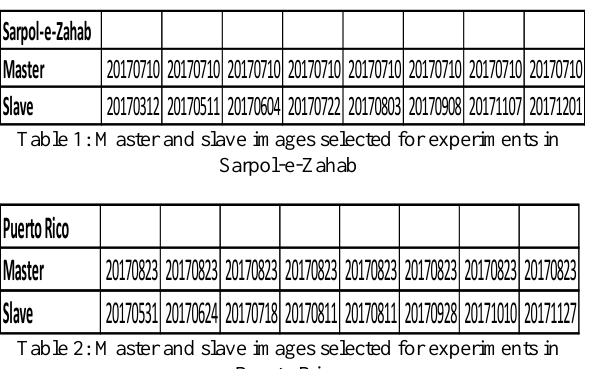
Figure 1: Thresholded coherence images of Sarpol-e-Zahab representing the periods before and after the